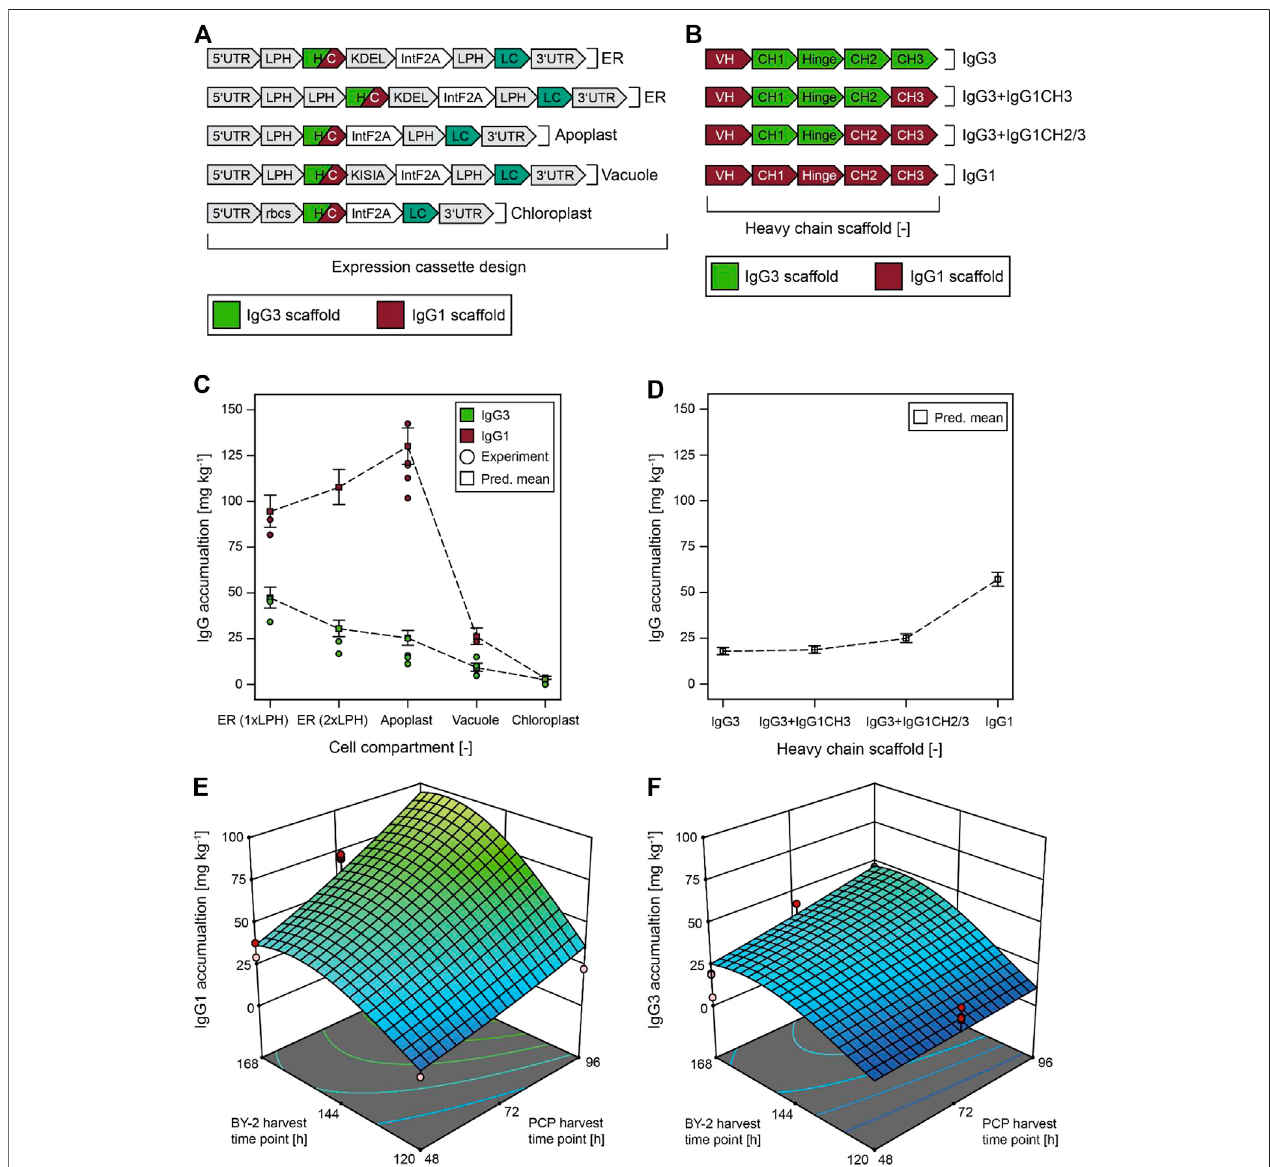
FIGURE1| ModelspredictingtheaccumulationofIgG3variantsandtheIgG1controlinBY-2PCPsdependingonthecompartment,theheavychainscaffold,and theBY-2/PCPharvesttimepoint(I-optimal designwith216runs). (A) SchematicofIgG3mRNAdesignfordifferentsubcellularcompartmentsinPCPsanddifferentiated plants. (B) IgGvariantsinvestigatedforproductaccumulationindifferentsubcellularcompartments. (C) Compartment-speci fi caccumulationofnativeIgG3andtheIgG1 control in the ER, apoplast, vacuole, and chloroplast. (D) IgG3 variant-speci fi c accumulation as an average over all compartments tested (see Supplementary Figure S3 for individual accumulation levels). BY-2 cultivation and PCP harvest times were 196 and 96 h respectively in both (C , D) . Error bars in (C , D) represent least signi fi cantdifference(LSD)barsaroundthepredictedmeans(non-overlappingLSDbarsindicatethatpredictionsatagivenfactorcombinationaresigni fi cantlydifferent). (E , F) Models predicting IgG1 (E) or IgG3 (F) accumulation in PCPs in the ER, dependent on the BY-2 and PCP harvest time points. Dots in (C , E , F) represent experimental data. CH – constant heavy chain antibody domain, ER – endoplasmic reticulum, HC – antibody heavy chain, LC – antibody light chain, LPH – N-terminal leader peptide of the antibody mAb24 heavy chain, PCP – plant cell pack, VH – variable heavy chain antibody